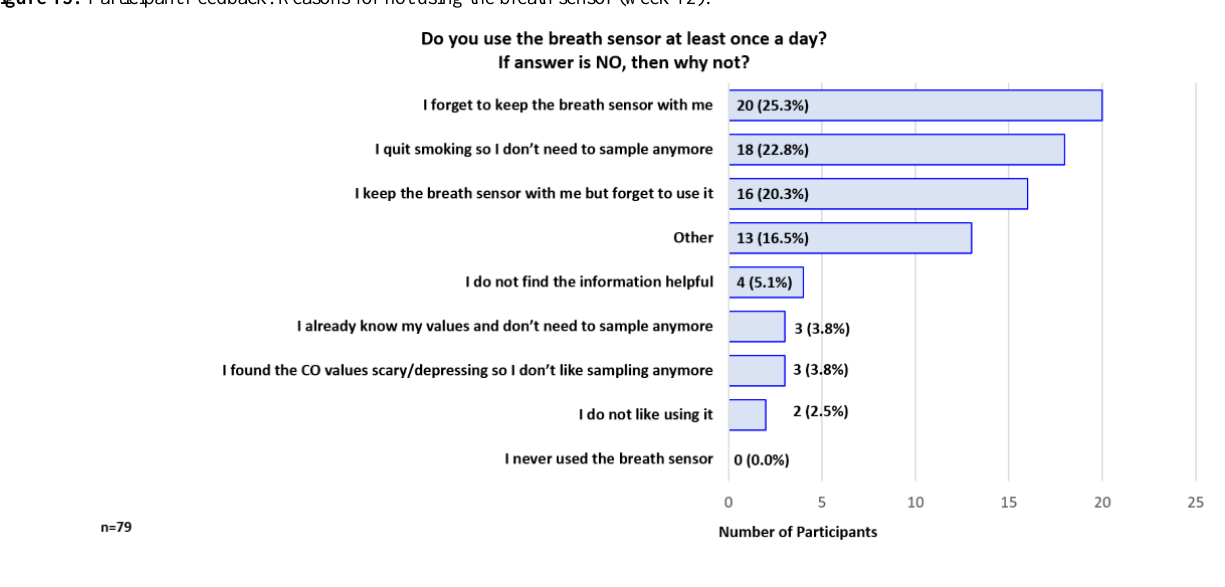
Figure 15. Participant Feedback: Reasons for not using the breath sensor (week